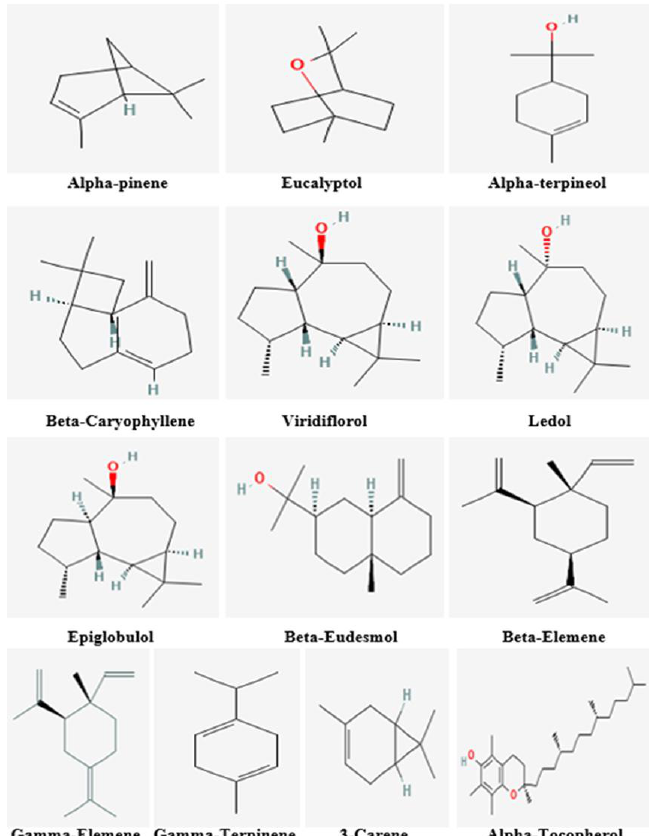
Figure. 3: Structures of the compounds of essential oil identified